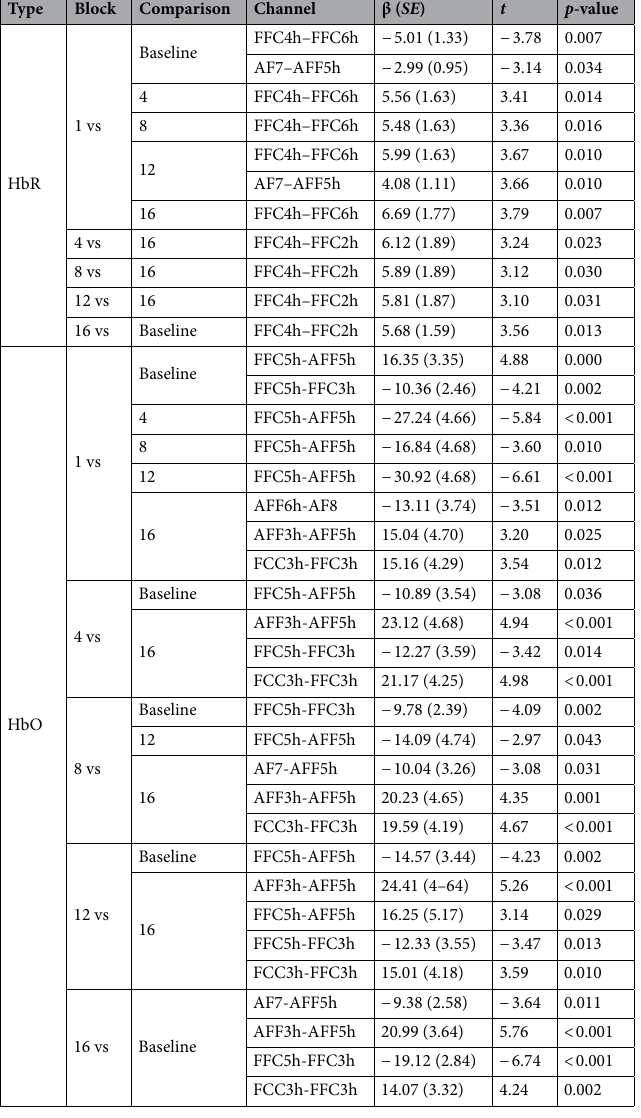
Table 4. Haemodynamic results for significant t-tests per channel in HbR and HbO. Comparisons against baseline (before task onset) and against other blocks are presented. df = 479. FDR-corrected p -values 38